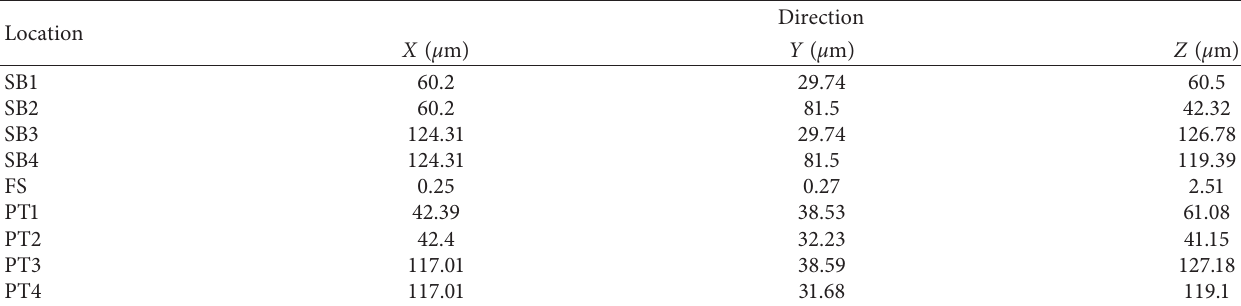
Table 5: Vibration displacements at points on coal crusher and